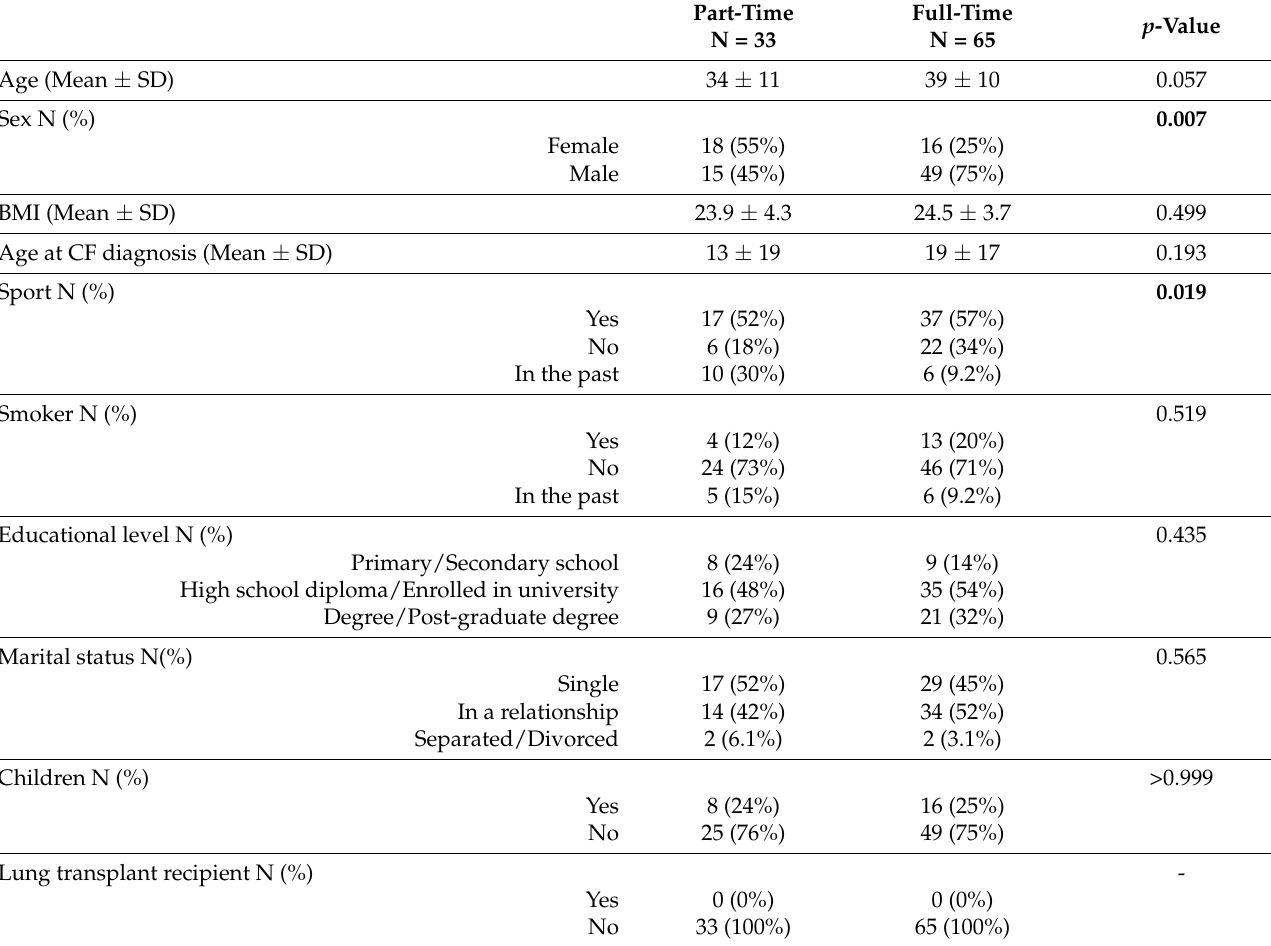
Table 2. Differences between part-time and full-time workers. Data are presented as frequency (percentages) for categorical data and as M ± SD for continuous data. p -values are computed with chi-square or Fisher test as appropriate for categorical data or with Student’s t test or Mann–Whitney U test as appropriate for continuous data. Significant values are marked in bold.